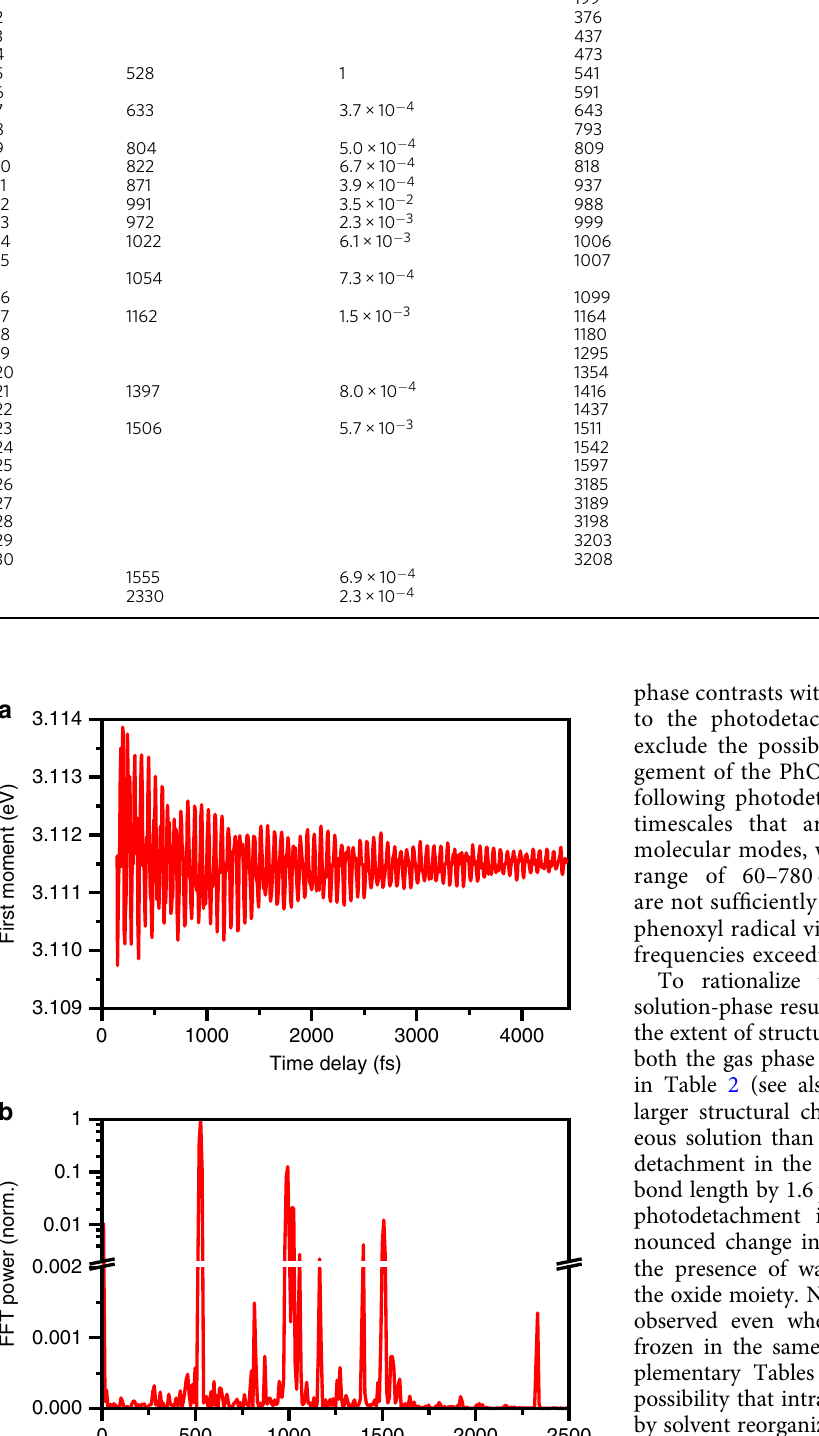
Table 1 Experimental and calculated vibrational frequencies of the phenoxyl radical in aqueous solution Freq. (cm – 1 ) Power (norm.)